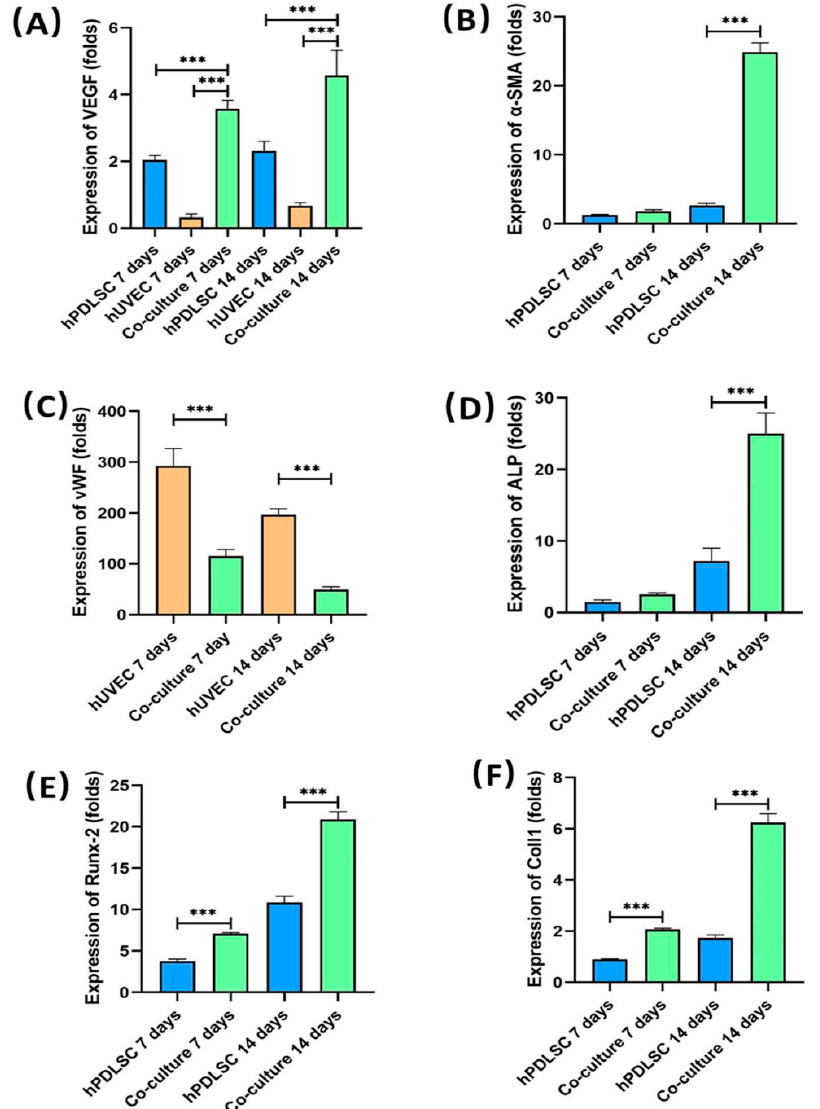
Figure 3. qRT-PCR assay of osteogenic and angiogenic genes at 1, 7, and 14 days: ( A ) VEGF, ( B ) α -SMA, ( C ) vWF, ( D ) ALP, ( E ) Runx-2, and ( F ) Coll-1. Co-cultured cells had higher angiogenic gene expression (VEGF and α -SMA) than monocultured hUVECs and hPDLSCs. The vWF expression of co-cultured cells was weaker than monocultured hUVECs. Additionally, the osteogenic gene expression (ALP, Runx-2 and Coll-1) of co-culture group was higher than monocultured hPDLSCs. *** p <